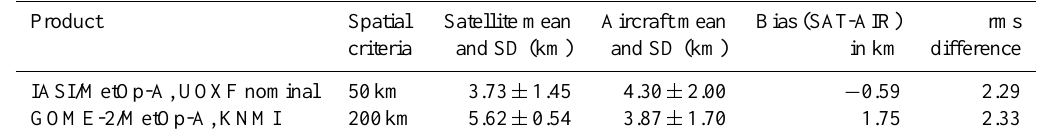
Table 7. Statistical mean values and associated standard deviation (SD) for the airborne lidar and the satellite ash plume height estimates.